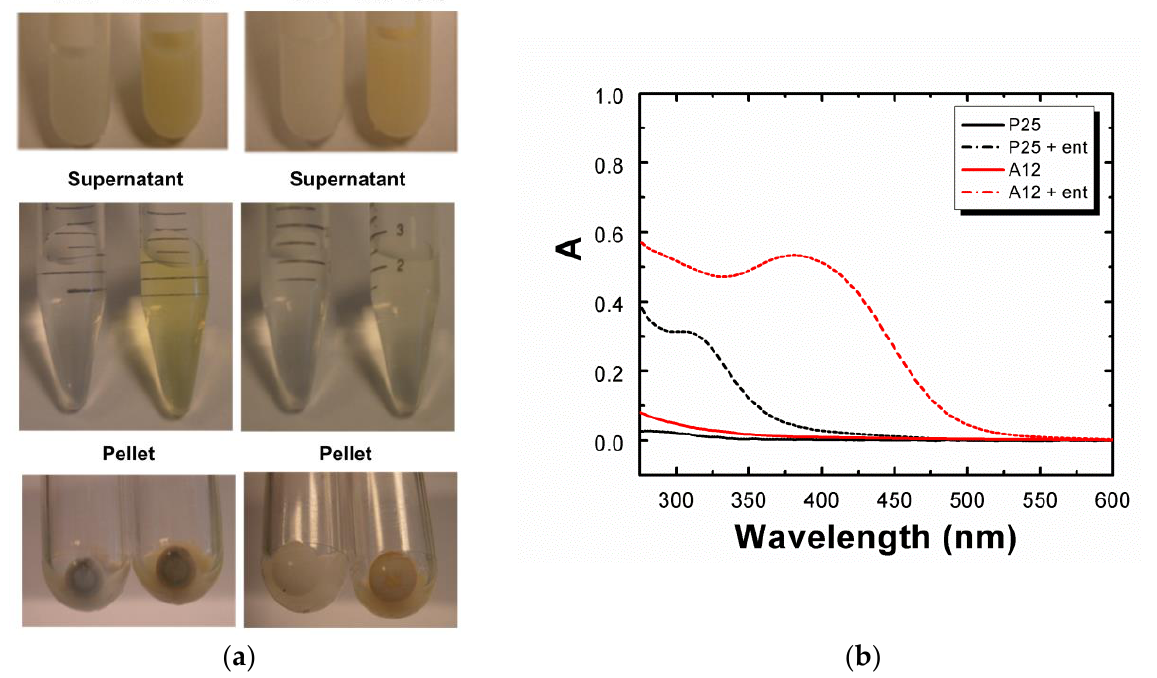
Figure 2. ( a ) Incubation of TiO 2 -A12 and P25 NPs at 5 mg/mL in a PP medium in the absence or presence of 50 µM enterobactin ( ent ) after 24 h at 37 °C. The supernatant (SN) and the pellets were then separated after an additional ultracentrifugation step at 75,000 rpm for 45 min at 5 °C. ( b ) UV – visible spectroscopy of the supernatants. A =